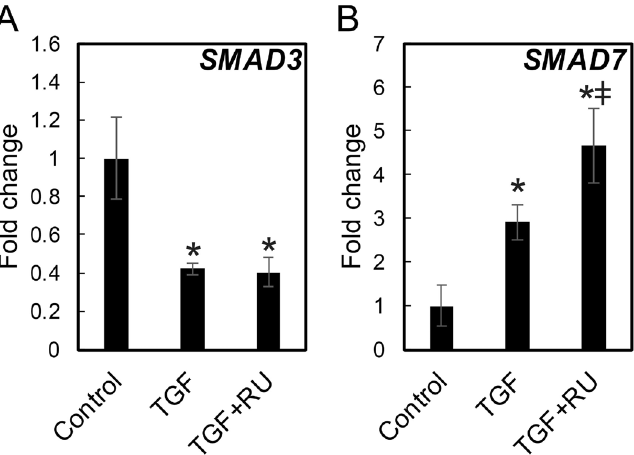
Figure 4. Expression levels of SMAD3 and SMAD7 genes in vocal fold fibroblasts after TGF ‐ β1 and RU486 administration. HVOX cells were treated with transforming growth factor-β1 (TGF-β; 10 ng/mL), dexamethasone (DM; 10 −7 M), and/or RU486 (RU; 10 −6 M) for 24 h. mRNA levels for smad3 ( A ) and smad7 ( B ) were examined by quantitative real-time polymerase chain reaction. Relative expression levels of each gene to GAPDH were compared with those of the control group, and are shown as mean ± SEM (n = 3). * P < 0.05 vs. control. ǂ P < 0.05 vs. TGF-β.